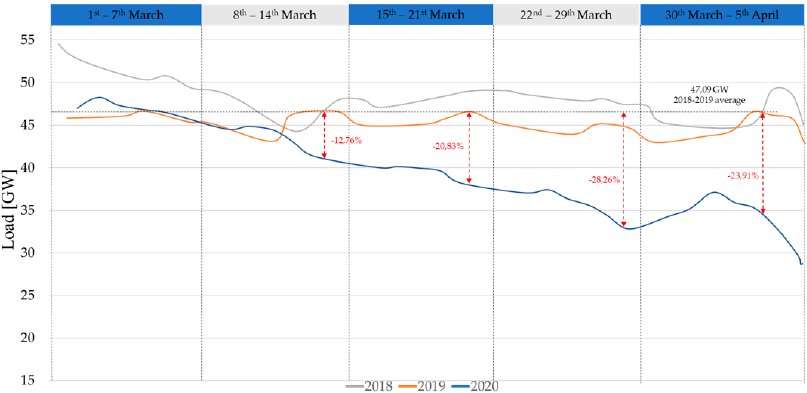
Figure 7. Five-week-peak comparison between 2018, 2019 and 2020.